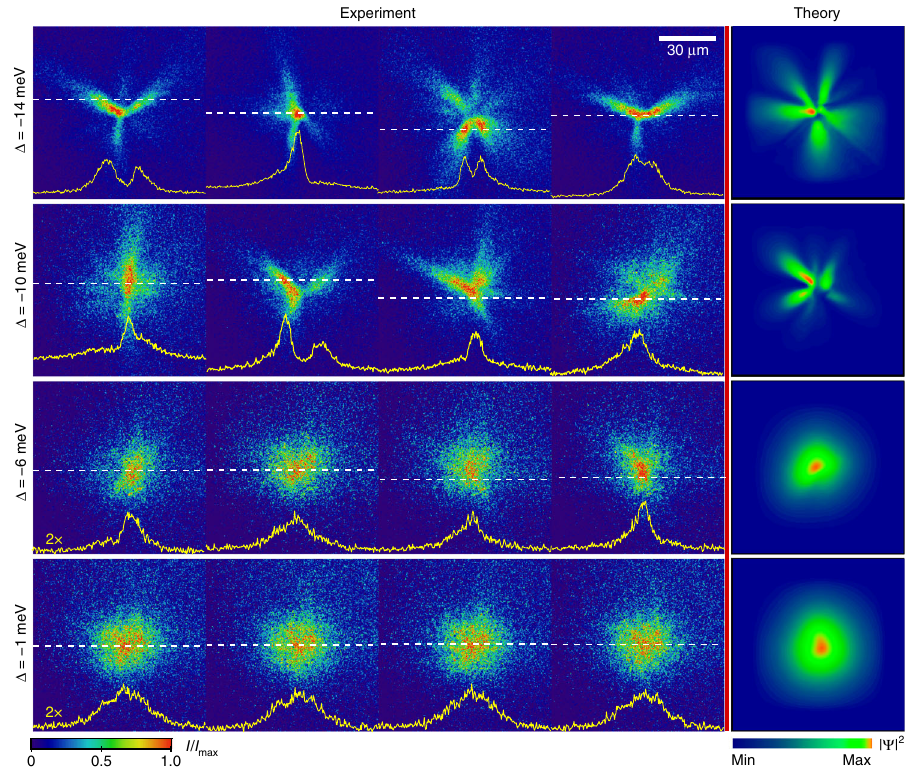
Fig. 3 Single-shot condensation for various detunings. Single-shot real space images of the photoluminescence intensity (proportional to polariton density) for P / P th ~ 6 and varying values of detuning Δ . Each panel represents a single realisation of spontaneous condensation and includes an image of the intensity pro fi le at a cross-section marked by a dashed line. Intensity is plotted on linear scale. The theory column shows polariton density obtained by numerical